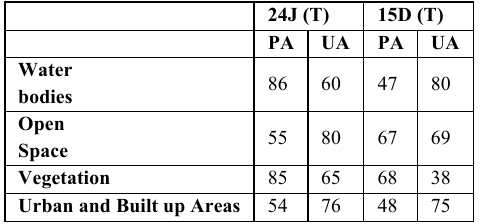
Table 2: Accuracy Assessment; PA: Producer's Accuracy; UA: User's Accuracy; 24J: 24th July; 15D: 15th December; (T): Texture Image Figure 2: H-A-Alpha Segmented Plane